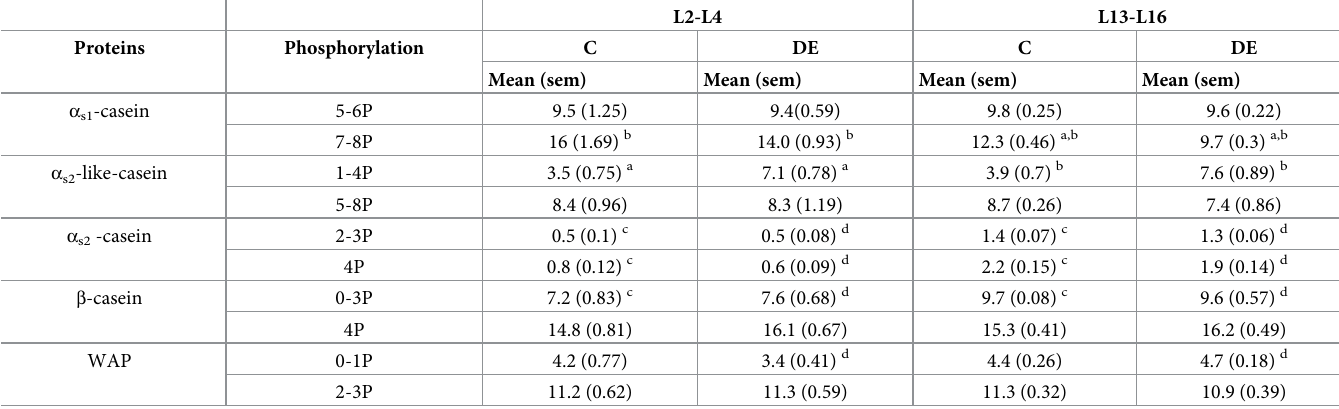
Table 4. Phosphorylation of major milk proteins from C and DE